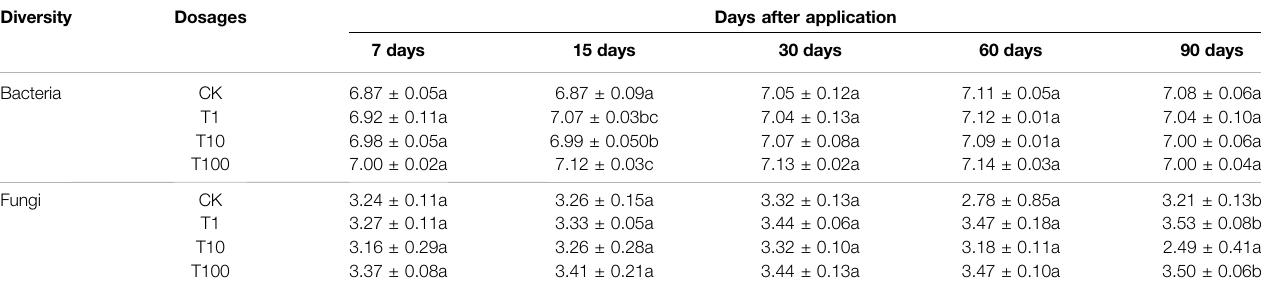
TABLE 2 | Shannon diversity index of bacteria and fungi in soil with different treatments and days. Diversity